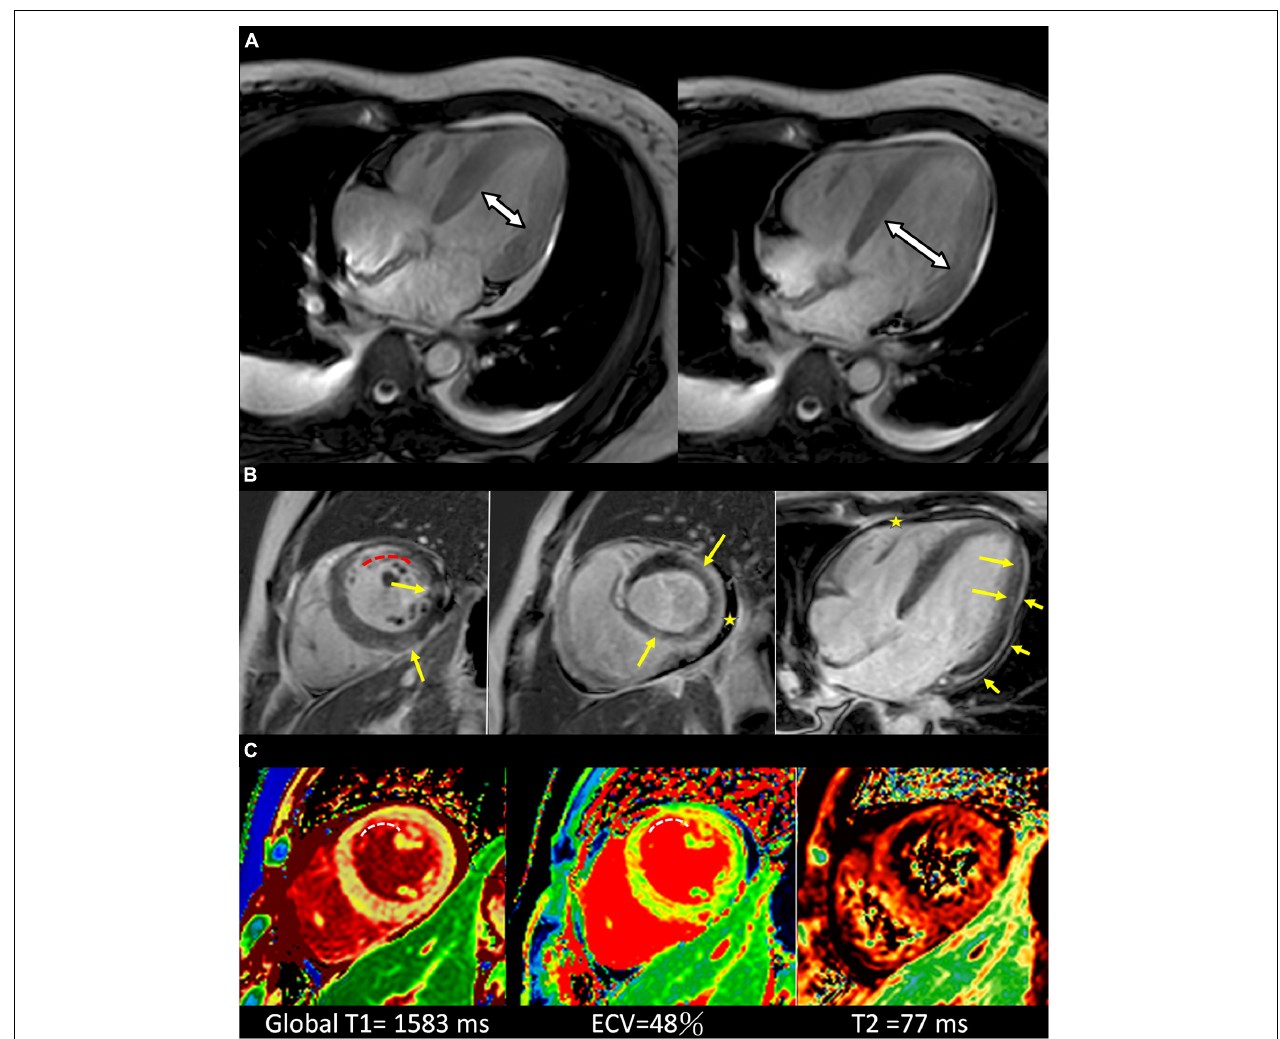
FIGURE 2 | Cardiac MRI of the patient. (A) Cardiac MR 4-chamber cine end-systolic (left) and end-diastolic (right) images show the limited LV dimensional change, indicative of the impaired LV systolic function. (B) Cardiac MR late Gadolinium enhancement images of short-axis (left, middle) and 4-chamber (right) view. Yellow arrows depict the patchy enhancements sparsely distributed in the mid-layer and subepicardium in a non-ischemic pattern, arrowheads depict pericardial enhancement and stars depict pericardial effusion. The curved dashed line depicts the subendocardial enhancement in the antero-septal subendocardium of LV mid-cavity which is within the LAD territory. (C) T1 map (left), ECV map (middle) and T2 map (right) in short-axis views show elevated T1, ECV, and T2 values, indicating acute myocardial injury (global T1 = 1,583 ms, ECV = 48%, T2 = 77 ms; institution-specific cut-off values for abnormal myocardium: T1 global ≥ 1,250 ms, T2 global ≥ 60 ms). CMR findings meet updated 2018 Lake Louise criteria for acute myocarditis (25). The curved dashed lines depict the focally elevated T1 and ECV values in the antero-septal subendocardium, equivalent to the enhanced area depicted in (B)